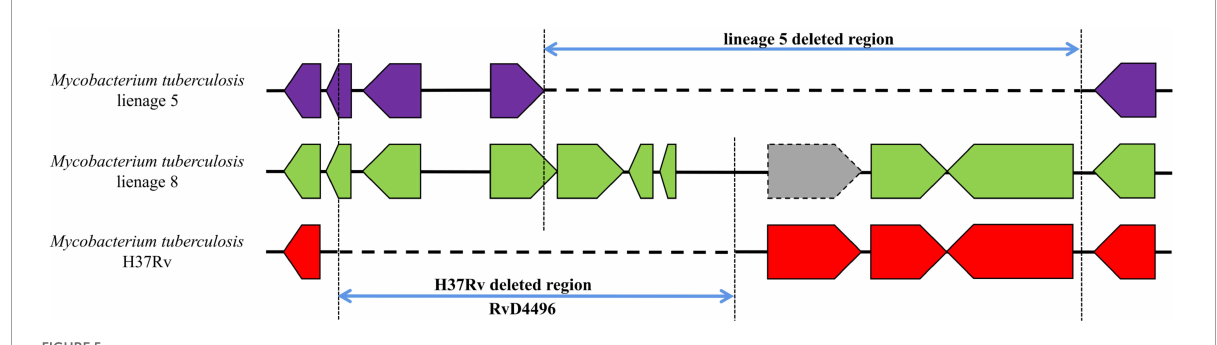
FIGURE5 Gene covariation of RvD4496 region in lineage 5, lineage 8 and H37Rv. Gray block represents